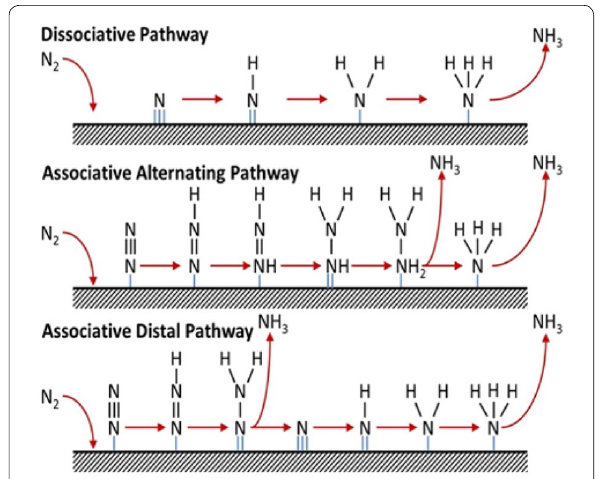
Fig. 1 Reaction mechanism for catalytic conversion of N 2 to NH 3 on heterogeneous catalysts (Reproduced with permission [24] Copyright 2016, Elsevier )